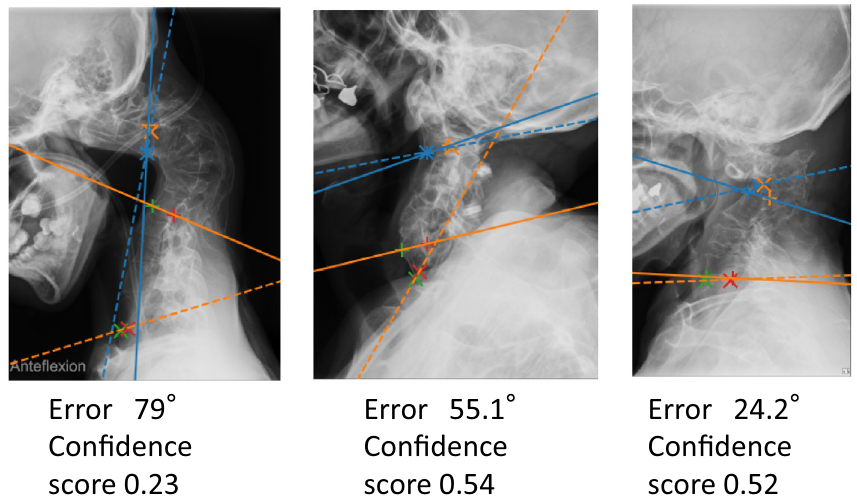
Figure 3. Three examples with measurement difficulties. In cases of fused vertebrae with a malformation, it is difficult for even surgeons to recognize the vertebrae correctly. The x-ray on the right is one of five cases in which two surgeons could not agree. The seemingly C2 vertebra was a malformed vertebra with multiple fused vertebrae. It is difficult even for surgeons to determine which part of this deformed vertebra is the original C2. Depending on which of the fused vertebrae is determined to be C2, the position of C7 will also change, which can easily lead to a large error. The solid lines represent the ground truth, and the dashed lines represent the measurement obtained by artificial intelligence.